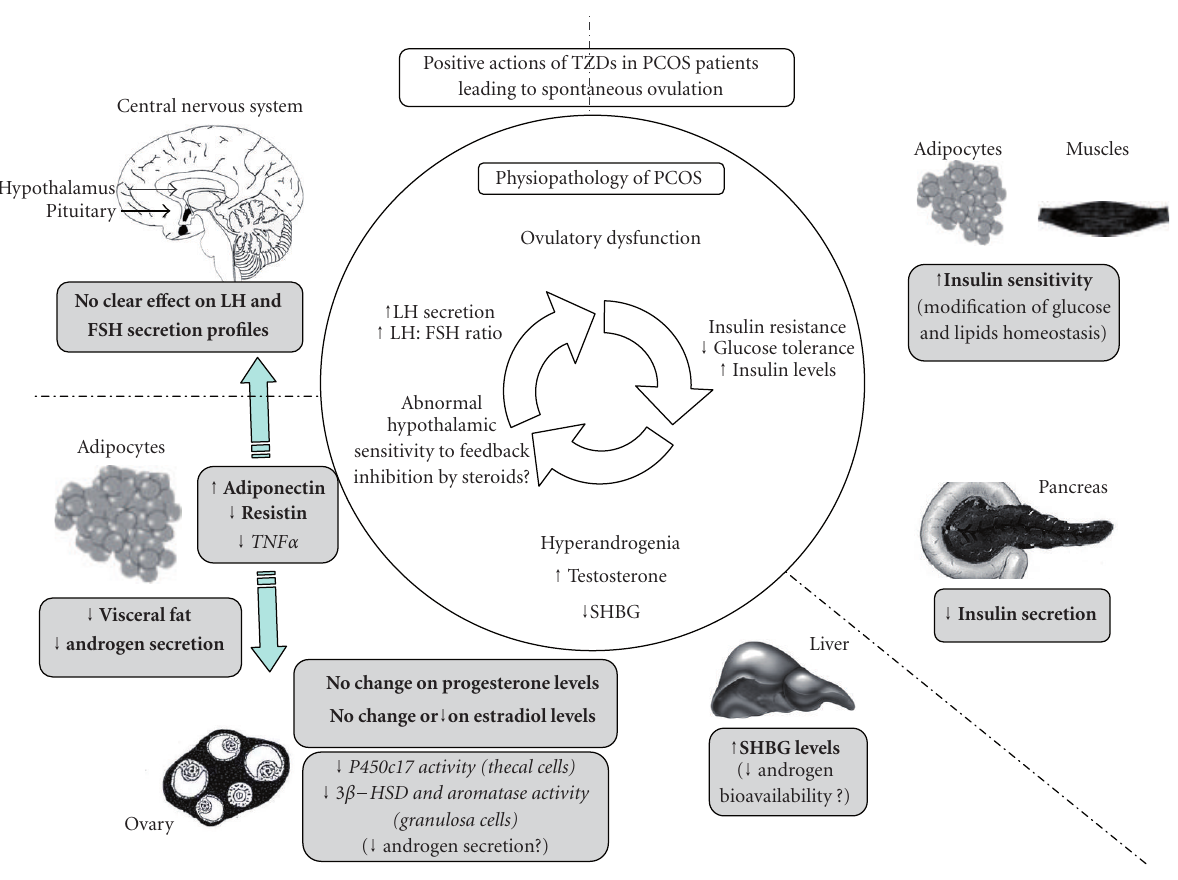
Figure 1: Positive actions of TZDs in PCOS patients leading to spontaneous ovulation. Three entrance points/major endocrine abnormalities (hyperandrogenia, insulin resistance, or LH hypersecretion) lead or maintain the ovulatory dysfunction of PCOS as represented in the inner circle of the figure. For example, high LH concentrations or insulin increase androgen secretion by human thecal cells [12] and could contribute to impair follicular development. In addition, elevated androgens could reduce hypothalamic sensitivity to negative steroids feedback, because administration of flutamide, an antiandrogen, can restore this sensitivity [13]. The positive actions of TZDs on PCOS patients could be mainly at two levels as described in the outer part of the figure. (1) TZDs increase the insulin sensitivity and decrease the insulin secretion. (2) TZDs reduce the androgen secretion and/or activity (in ovary and/or in adipose tissue). Finally, TZDs can modulate secretion of several endocrine hormones (adiponectin, resistin, TNF α ) which can reduce androgen production or improve gonadotropin secretion. The boxes show results obtained in vivo in PCOS women (in bold) or in vitro in human cell culture (in